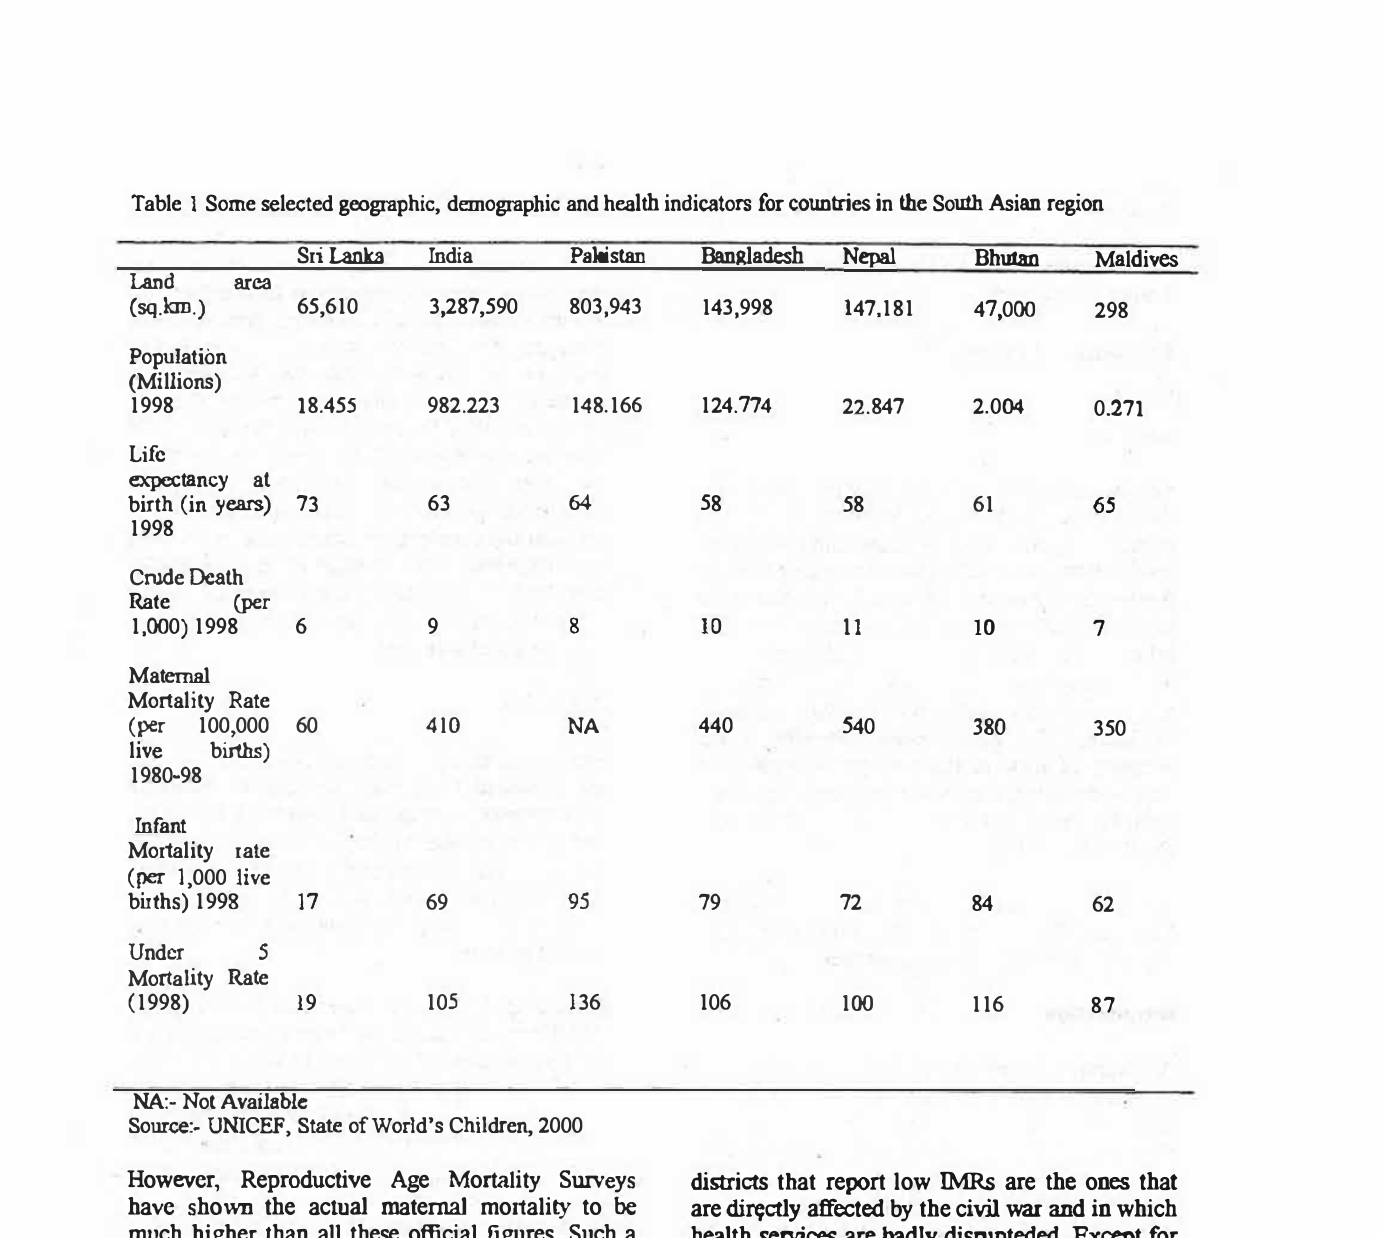
Table 1 Some selected geographic, demographic and health indicators for countries in the South Asian